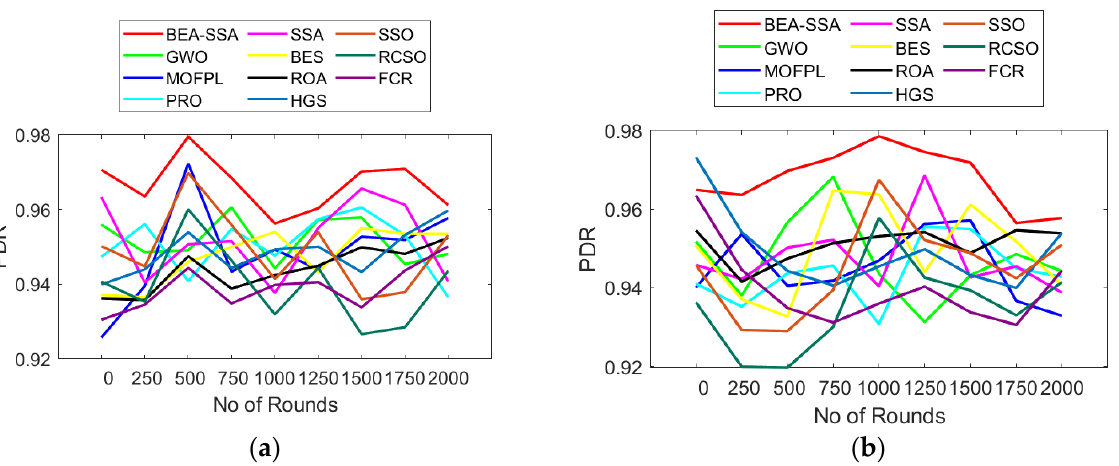
Figure 9. PDR analysis using BEA-SSA compared with the other models [20–22,26] for node counts of ( a ) 100 and ( b ) 200.